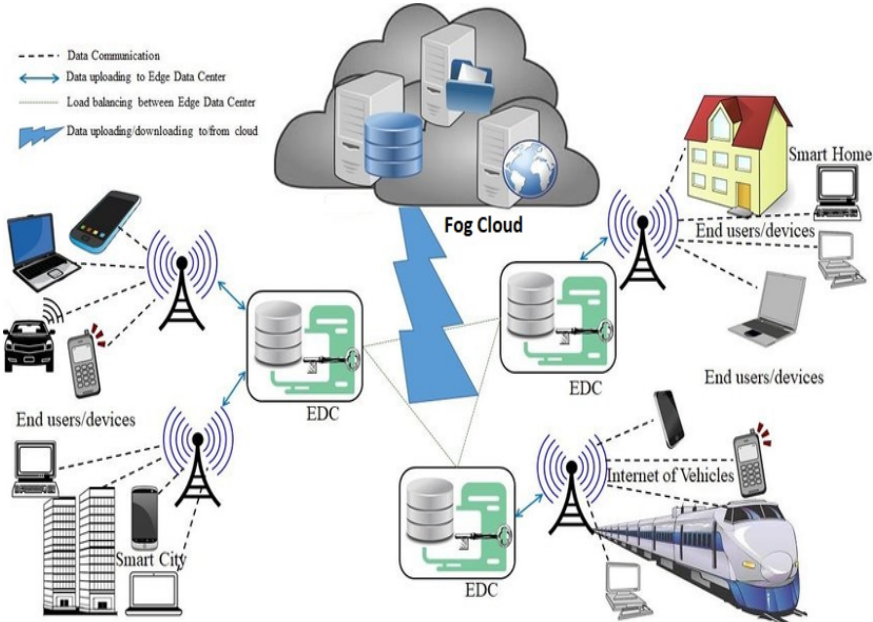
Figure 4. Applications of Fog